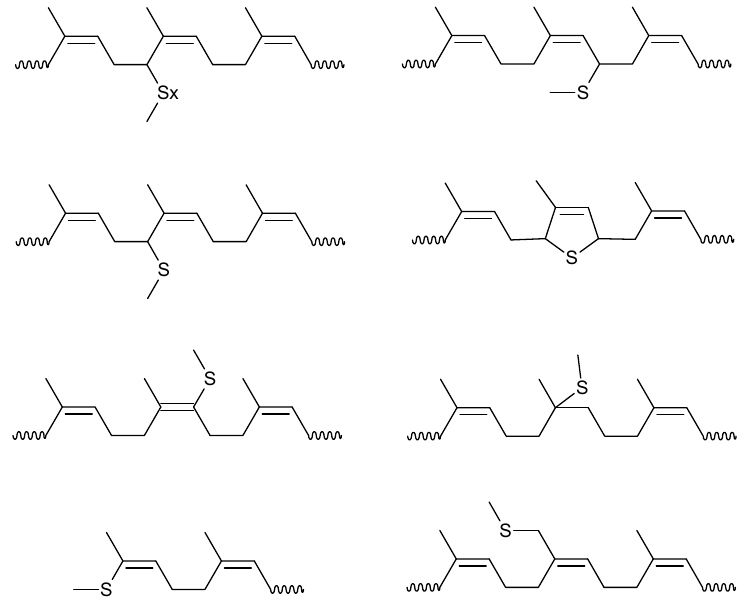
Figure 5. Proposed structures that are produced through the vulcanization of cis -PI [38]. Adapted with permission from Ref. [38]. Copyright (2022) Elsevier Inc.